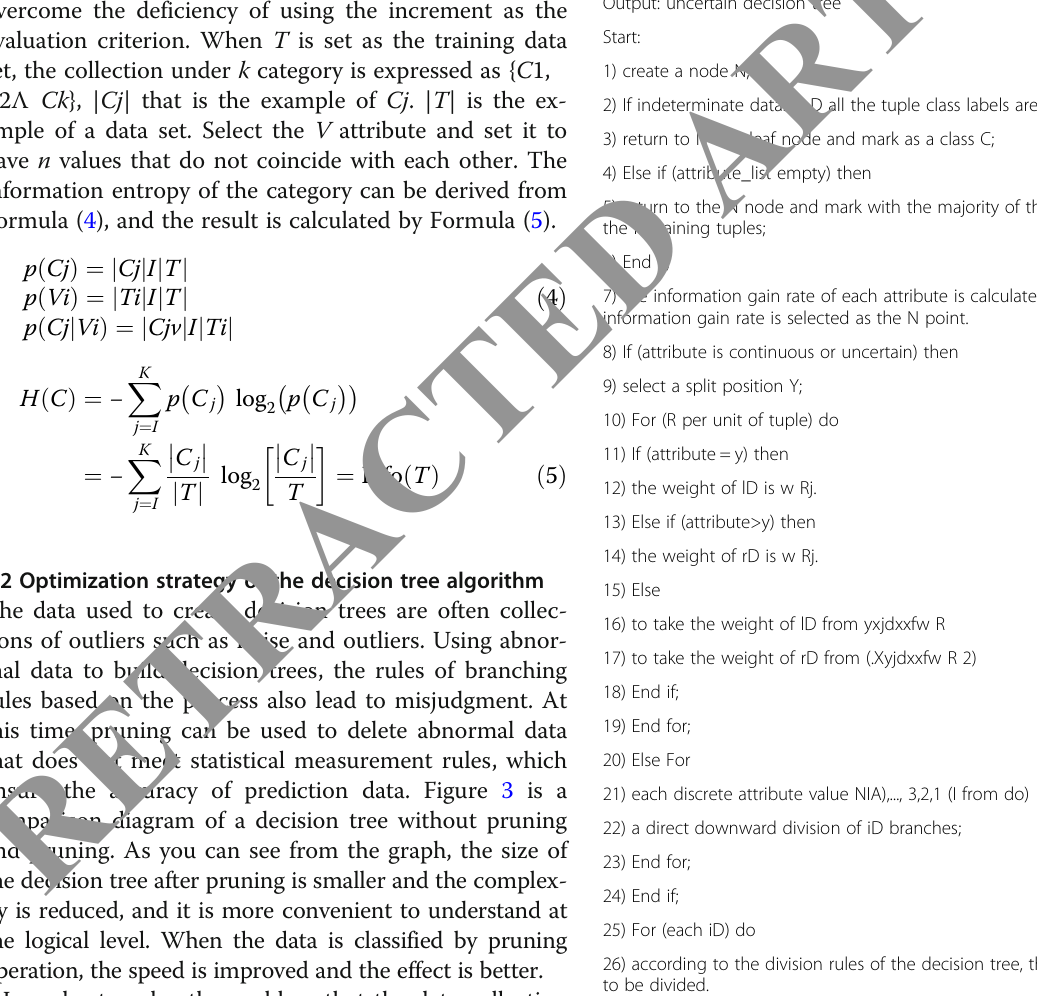
Table 1 Construction process of the uncertain C4.5 decision